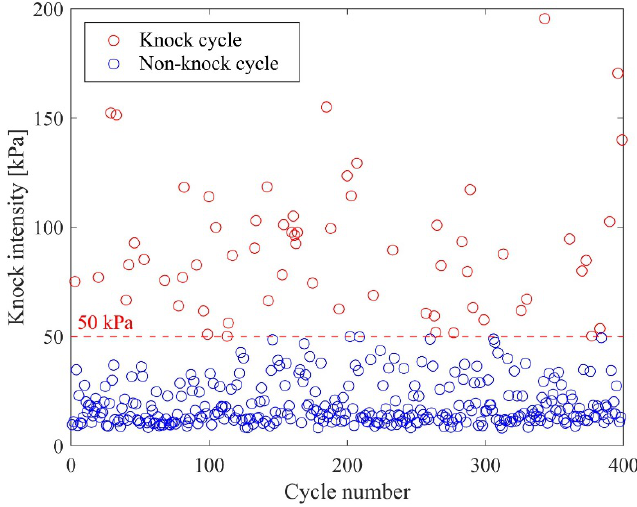
Figure 2. Knock intensity for each cycle.